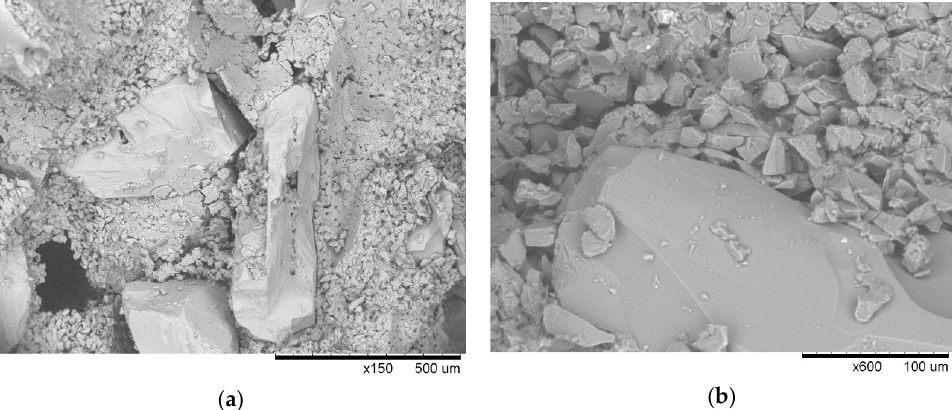
Figure 21. SEM morphology of PW2 sample cross section: ( a ) ×150; ( b ) ×600.